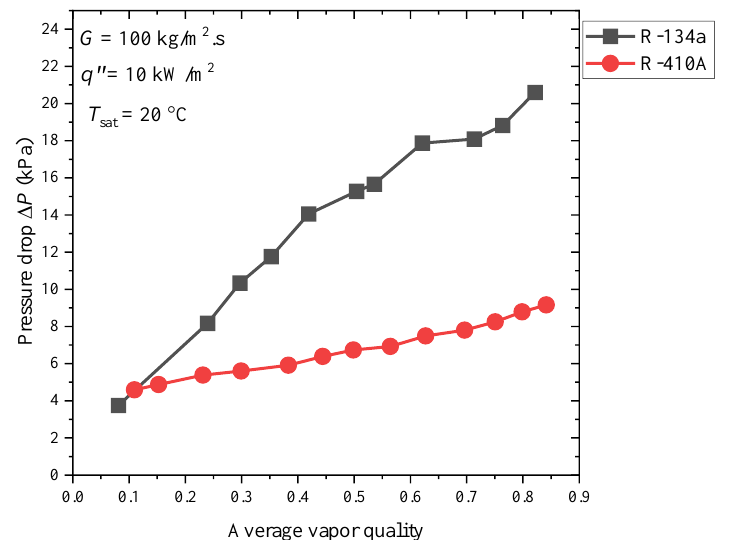
Figure 17. Comparative pressure drops of R-134a and R-410A inside the plate heat exchanger. Solid and rectangular solid connected line presents the Kuo et al. [73] and Yan et al. [74] study respectively. Soontarapiromsook et al. [74] investigated the influence of surface roughness’s of 0.594 µ m (considered as a smooth surface), 1.816 µ m, and 2.754 µ m on the condensation HTC and pressure drop for R-134a inside a plate heat exchanger at a condensation temper- plate surface was higher than that of the smooth plate surface by about 31 to 44%, while